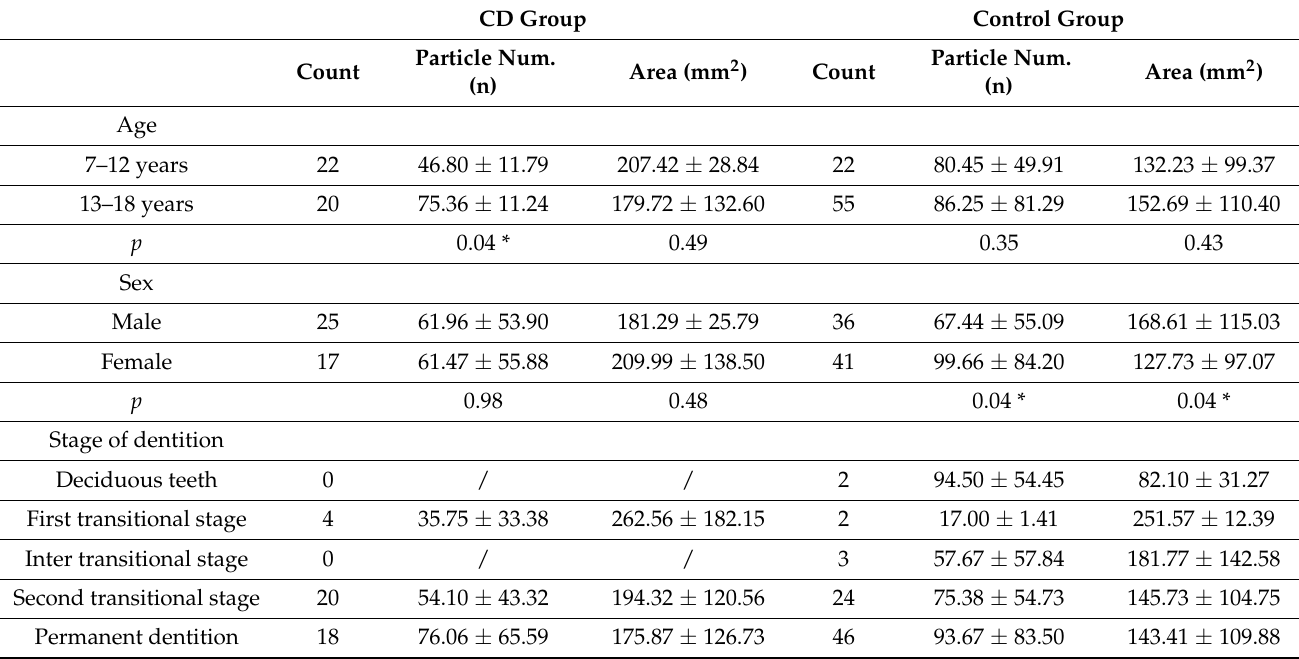
Table 3. Results of masticatory efficiency for patients with craniofacial disorders (CD, n = 42) in comparison to the control group (n = 77). Means and standard deviations are given for both particle number (n) and area (mm 2 ), as well as the patient count for each calculation. Results are differentiated by age (7–12 years; 13–18 years), sex and stage of dentition. Statistical significance was considered at p < 0.05 and denoted with (*). CD Group Control